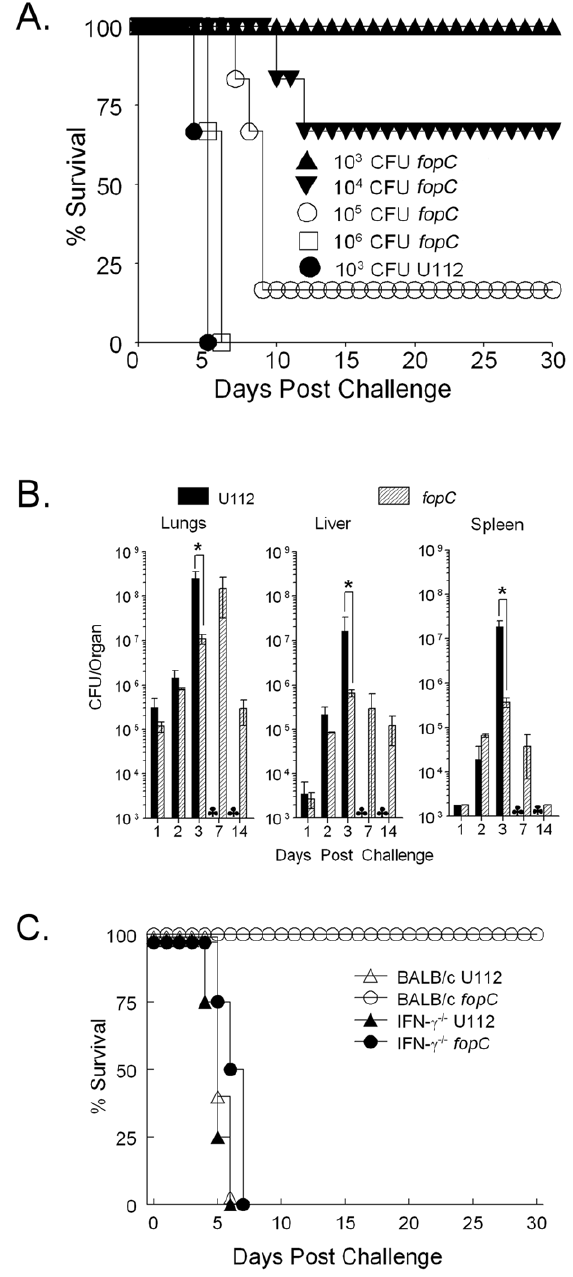
Figure 2. Virulence of the fopC mutant. (A) BALB/c mice (6/group) were challenged i.n. with 10 3 CFU U112 or increasing inocula (10 3 – 10 6 CFU) of fopC mutant. All animals were monitored daily for survival for 30 days. (B) BALB/C mice were challenged i.n. with 10 3 CFU wildtype U112 or fopC mutant. Organs (lungs, liver and spleen) were collected on days 1, 2, and 3 from mice (n=3 mice at each time point) infected